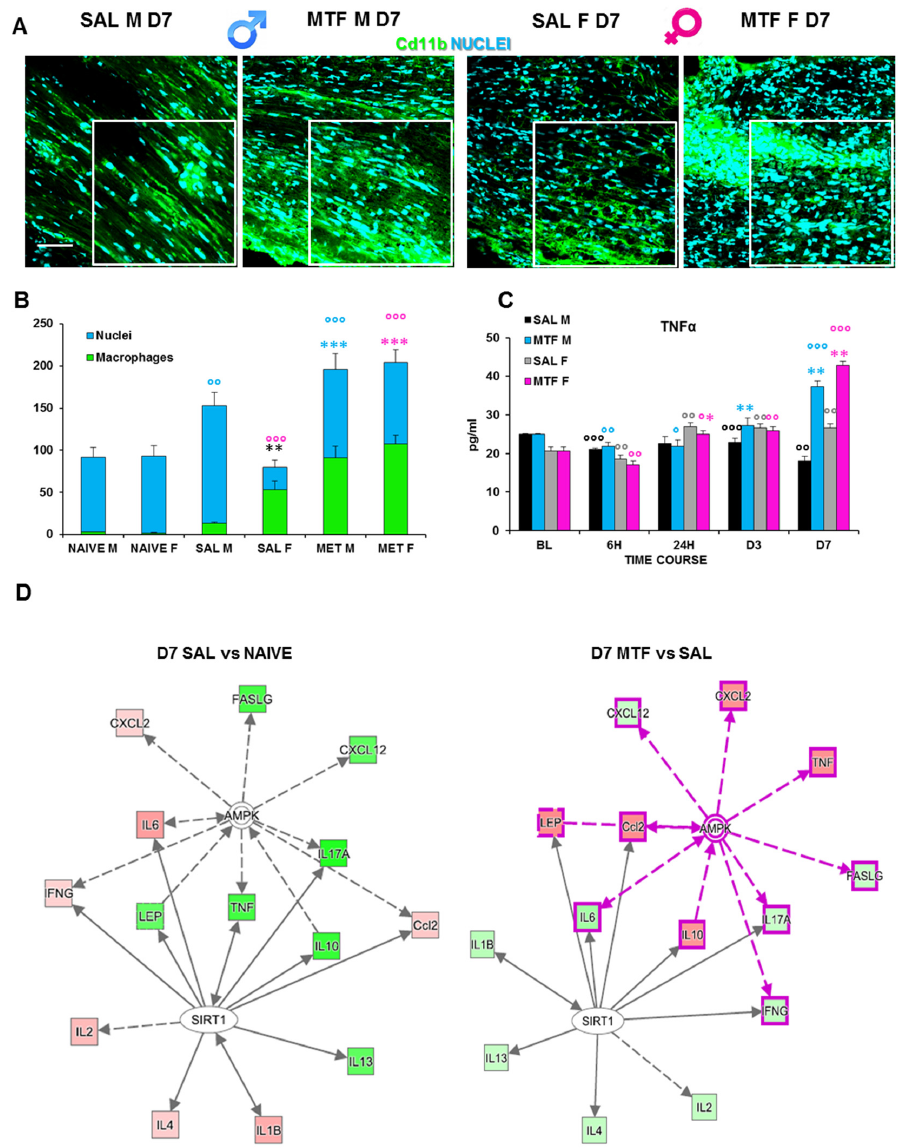
Figure 4. Effects of MTF administration on macrophages at D7 after peripheral nerve injury in male and female mice. ( A ) Sample of confocal images (high magnification 63×, in the selected square zoom 1×, scale bar 50 u) of CD11b (macrophages cell marker, green) positive cells (cyan nuclei) in lesioned sciatic nerves (7 days after CCI) of male and female mice. ( B ) Cd11b cells count (n = 3 animals/group 2/3 slices/animals—H 5,6 : 29,080 p : < 0.0001); T-test comparison: ** (black) vs. SAL M p < 0.005; *** (blue or pink) vs. SAL M or F respectively p < 0.0001; °°°, °° (blue or pink) vs. naive M or F respectively p < 0.005 and p < 0.0001. ( C ) Time-course (BL-baseline, 6 h–6 h, 24 h, day 3–D3 and D7 after CCI) of TNF α levels in sciatic nerve lysates of male and female mice. (n = 3/group/time-point) males: H 8,9 : 21,6 p = 0.0057; females: H 8,9 : 26,527 p < 0.0009; Unpaired t-test comparison: °, °°, °°° vs. BL p < 0.05, 0.005, 0.0001 respectively; *, **, *** vs. SAL p < 0.05, 0.005, 0.0001 ( D ) Schematic repre- sentation deriving from Ingenuity Pathway Analysis of molecular interactions and networks of proteins found variated (red, upregulated and green, downregulated) in females and males 7 days after nerve ligature (left, gray-gray network: saline vs. naive; right, pink-gray network: metformin vs. saline). A solid line represents a direct interaction between the two gene products, and a dotted line means there is an indirect interaction.